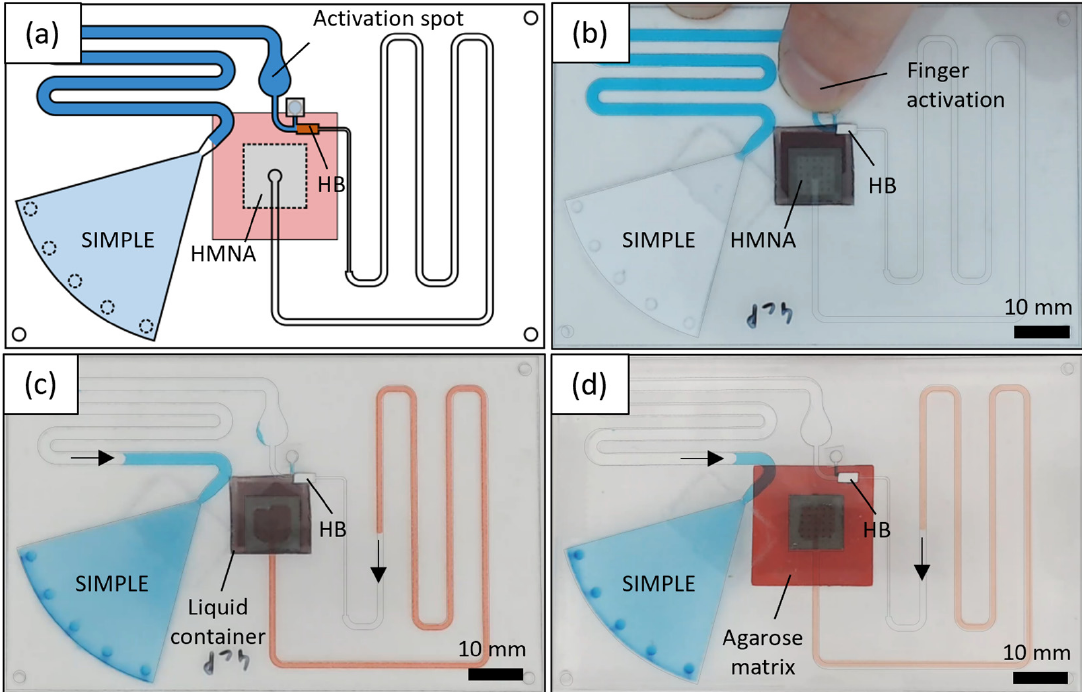
Figure 7. ( a ) Design of the sampling patch used in this experiment. ( b ) Snapshot of a sampling patch during finger press activation. ( c ) Sampling blood-mimicking fluid from an open liquid container. Arrows indicate the direction of the fluid flow. ( d ) Sampling patch while sampling from agarose skin-mimicking matrix. Arrows indicate again the direction of the fluid flow.